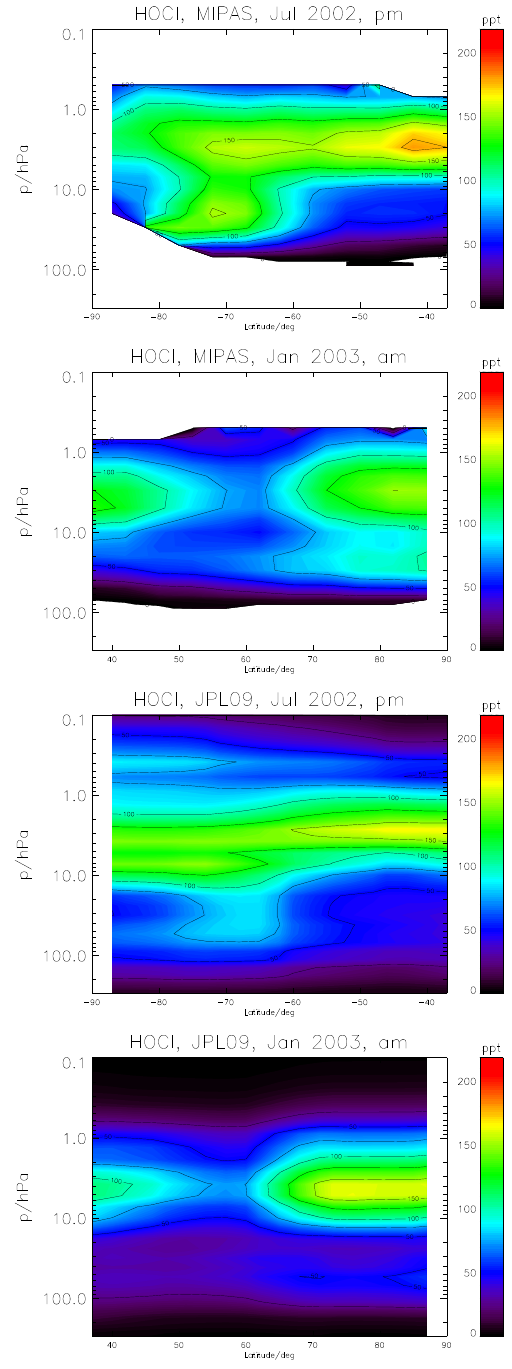
Fig. 6. Zonal mean morning (top panel) and evening (second panel) HOCl distribution in Arctic winters (December 2003). Note low values in sub-polar regions. The third and fourth panel represent the respective model data sets.